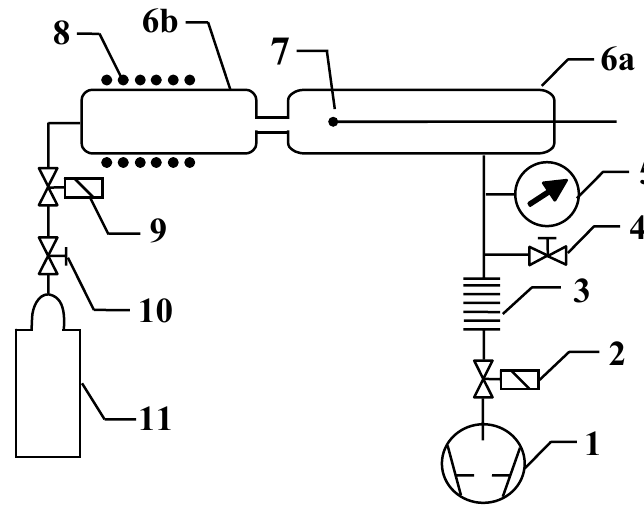
Figure 1. Experimental setup: 1. rotary pump; 2. gate valve; 3. Hopkins trap; 4. air inlet valve; 5. vacuum gauge; 6a. discharge chamber; 6b. post-discharge chamber; 7.